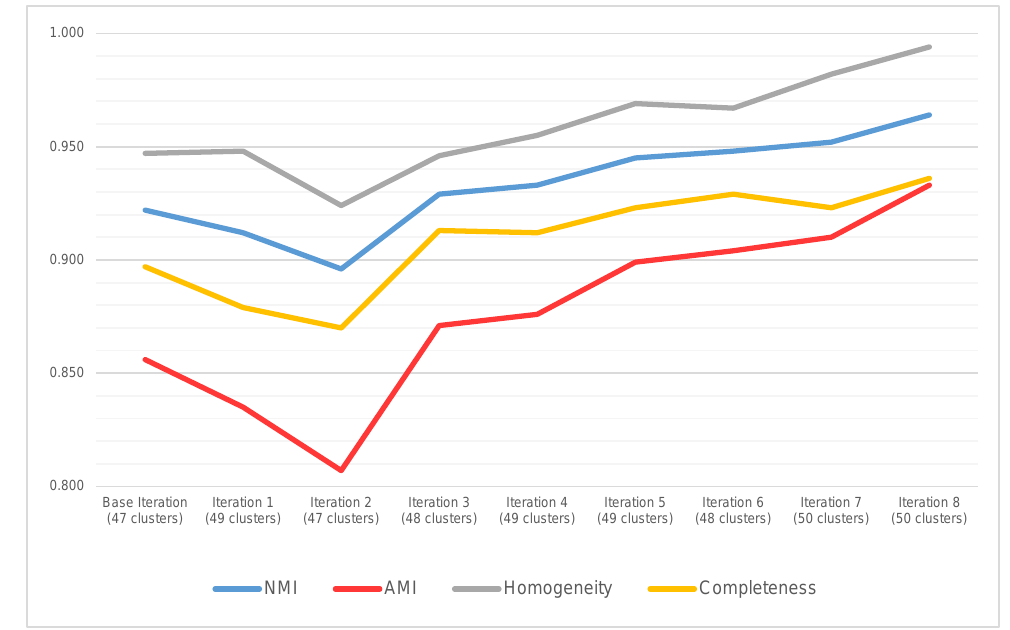
Figure 3. Performance of the semi-supervised methodology against the ground truth.